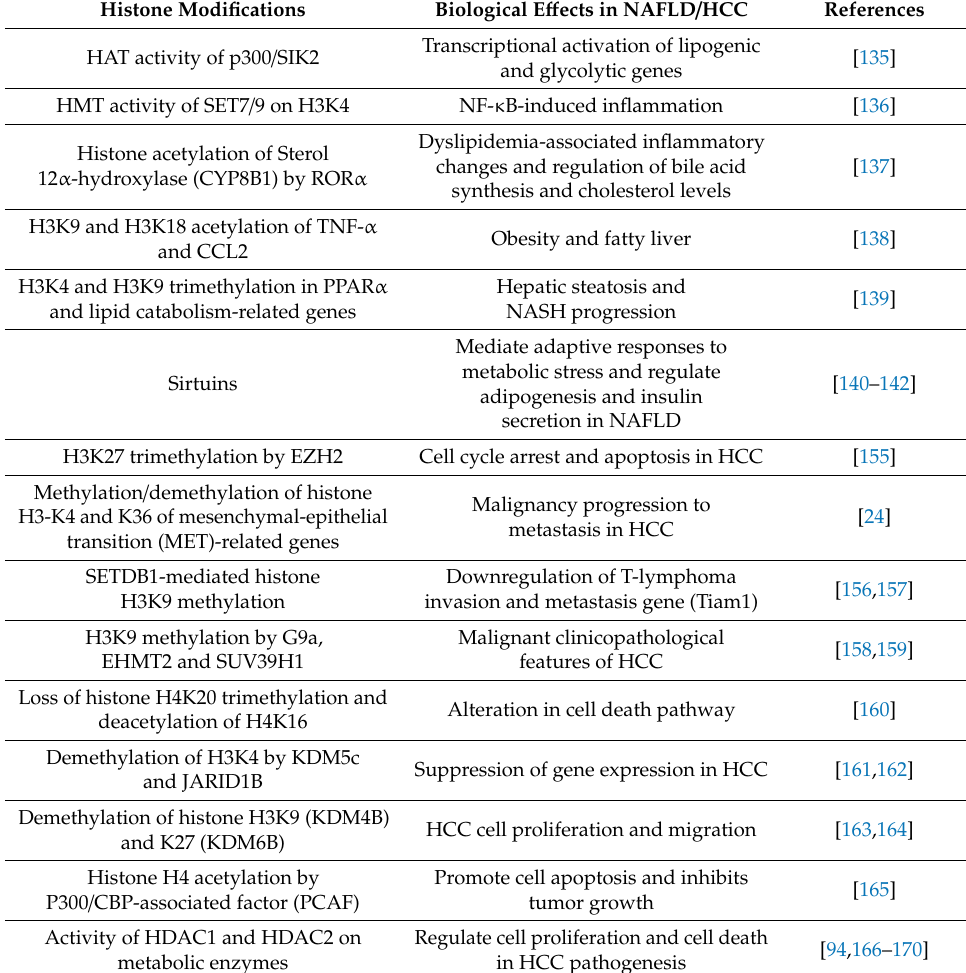
Table 2. Histone acetylation- / methylation-mediated epigenetic changes in nonalcoholic fatty liver disease (NAFLD) and hepatocellular carcinoma (HCC) that leads to apoptotic pathway